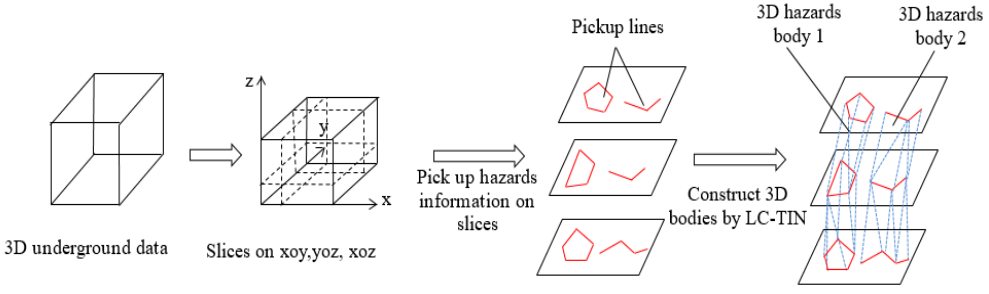
Figure 6. Process of 3D geological data modeling.